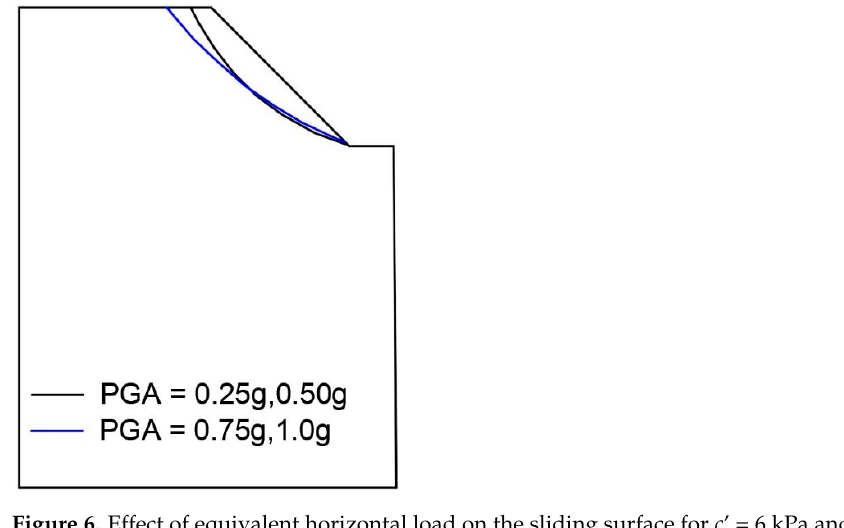
Figure 6. Effect of equivalent horizontal load on the sliding surface for c ’ = 6 kPa and φ ’ = 30°.